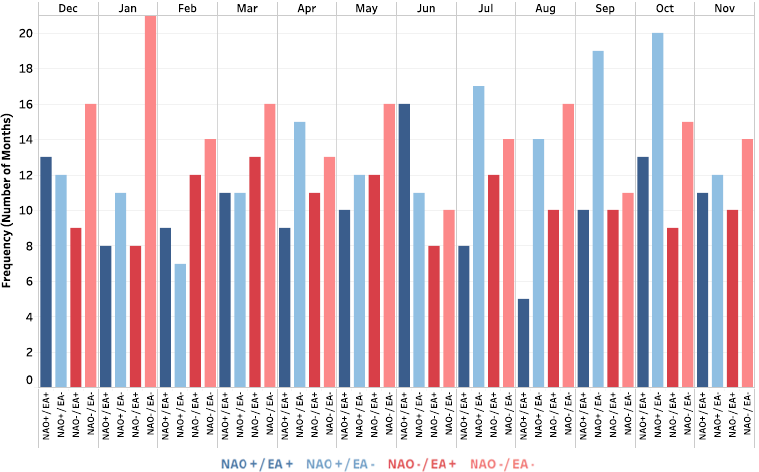
Figure 1. Frequency Analysis of NAO/EA Positive and Negative Phases.